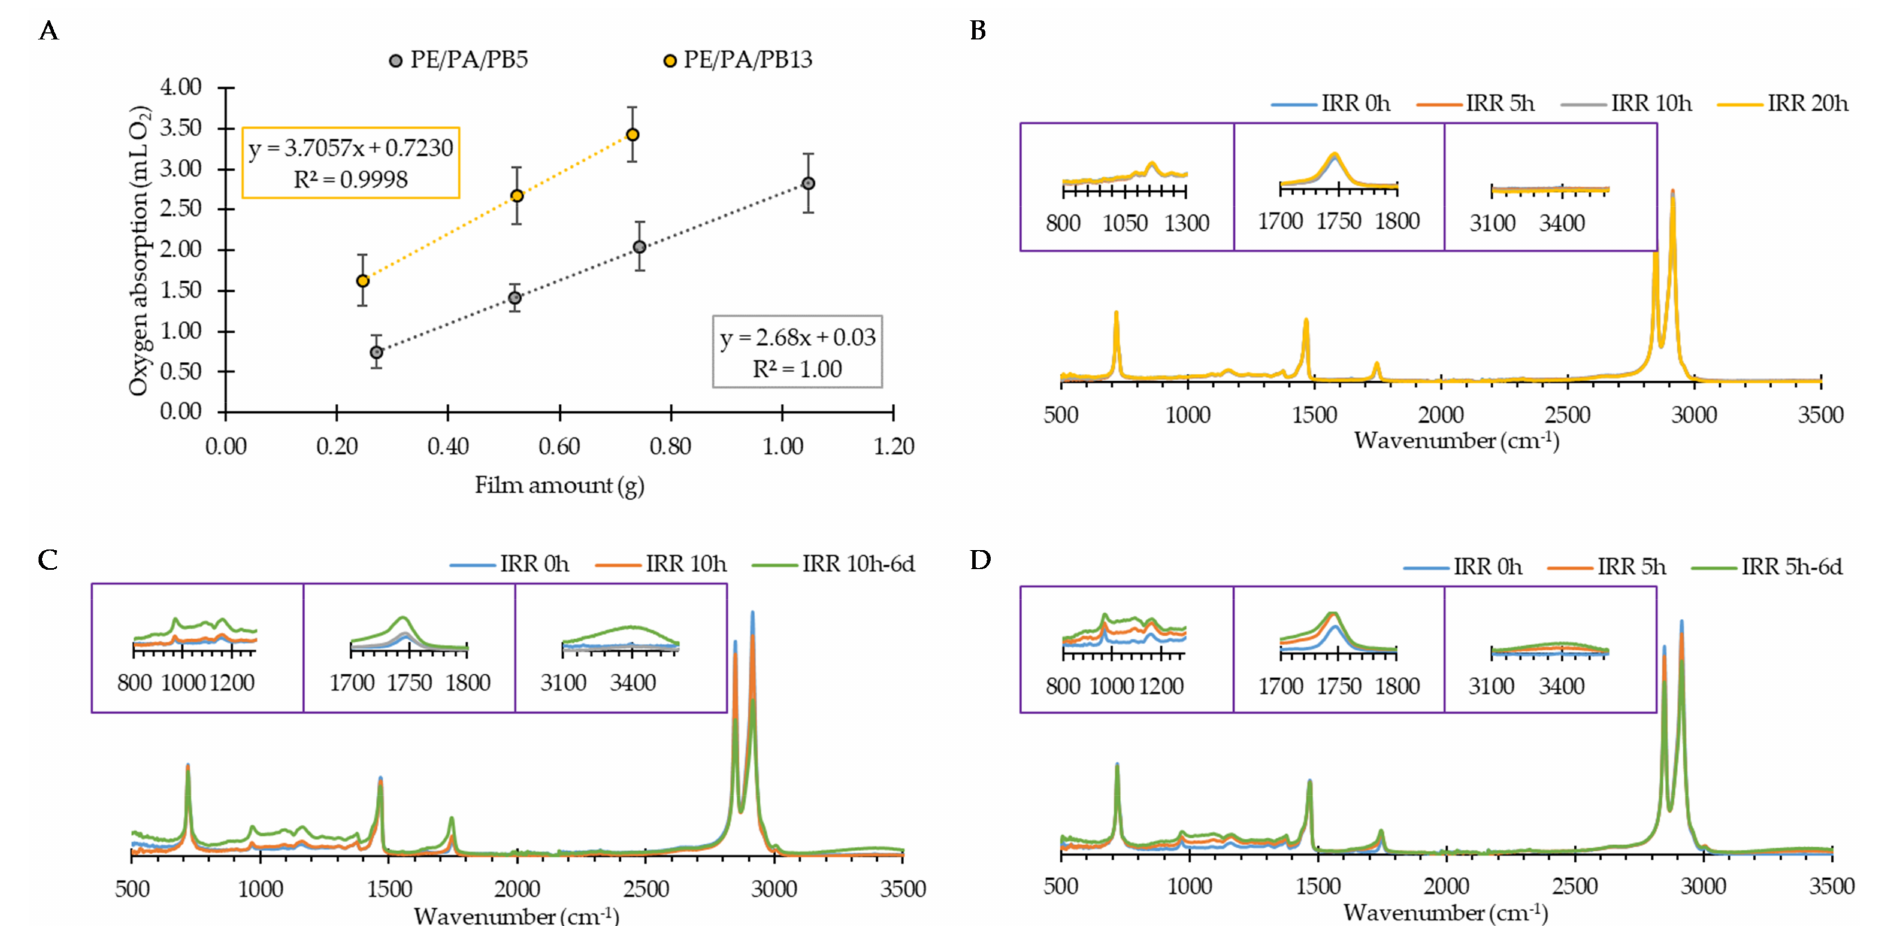
Figure 4. Relationship between oxygen absorption (mL O 2 g − 1 film) and the amount of film (g) ( A ), FTIR spectra of PE/PA ( B ) after UV irradiation for 5 (IRR 5 h), 10 (IRR 10 h) and 20 h (IRR 20 h) and of PE/PA/PB5 ( C ) and PE/PA/PB13 ( D ) films after UV irradiation for 10 and 5 h, respectively and after 6 days of oxidation (IRR10 h-6 d and IRR 5 h-6 d) in air at 30 ◦